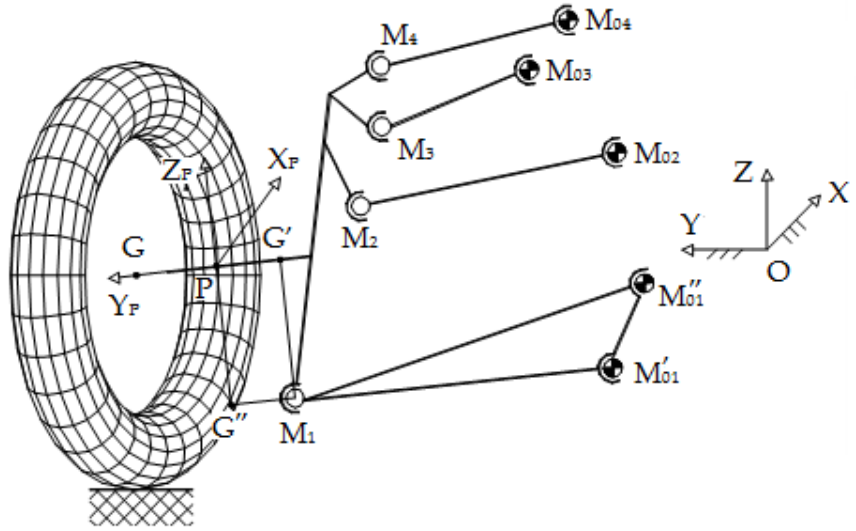
Figure 4. The global (car body) and local (wheel carrier) reference frames.